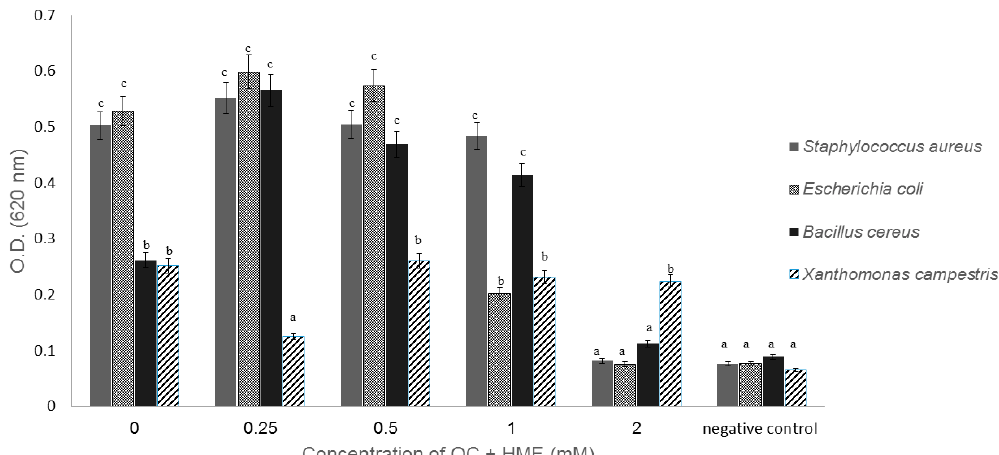
Figure 3. The e ff ect of 4-quinolinecarboxaldehyde (QC) and 5-hydroxymethyl-2-furaldehyde (HMF) on the growth of several Gram-negative and Gram-positive bacteria; di ff erent concentrations of QC and HMF were applied to bacterial cultures (5 µ L containing approximately 10E8 cells / mL and 150 µ L NB medium). The amount of each bacterium, represented by turbidity, was read by an ELISA plate reader 24 h post inoculation and incubation at 28 ◦ C. A sterile medium was used as a negative control. Each treatment was performed in five repeats. Di ff erent letters represent significant di ff erences in growth between treatments ( t -test, p < 0.05). Standard error bars are shown.